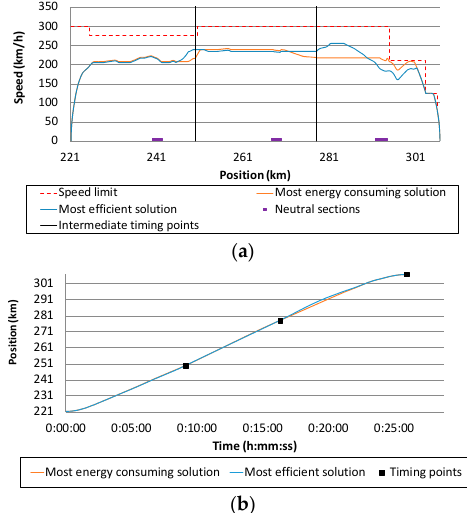
Figure 12. Speed profile ( a ) and position evolution with time ( b ) of the most efficient and most energy consuming solutions found by the algorithm for the case of two intermediate timing points.